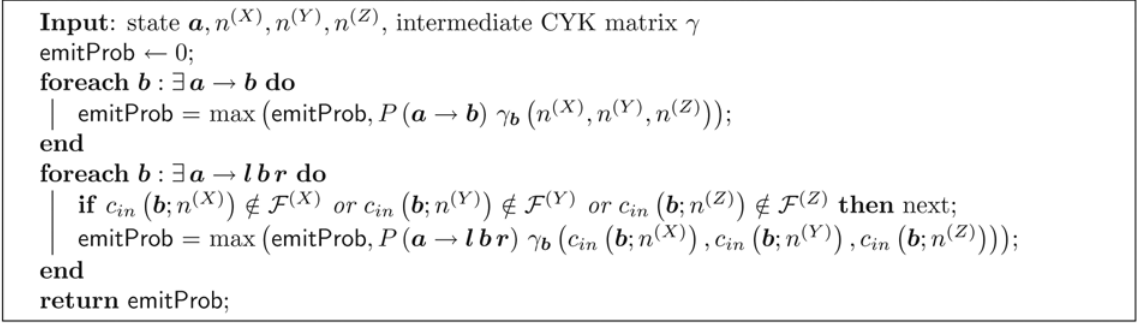
Figure 4. Algorithm 4. Subroutine calcTransEmitProb() for the CYK algorithm. a and b are ensemble states; l and r are left and right terminal emissions.